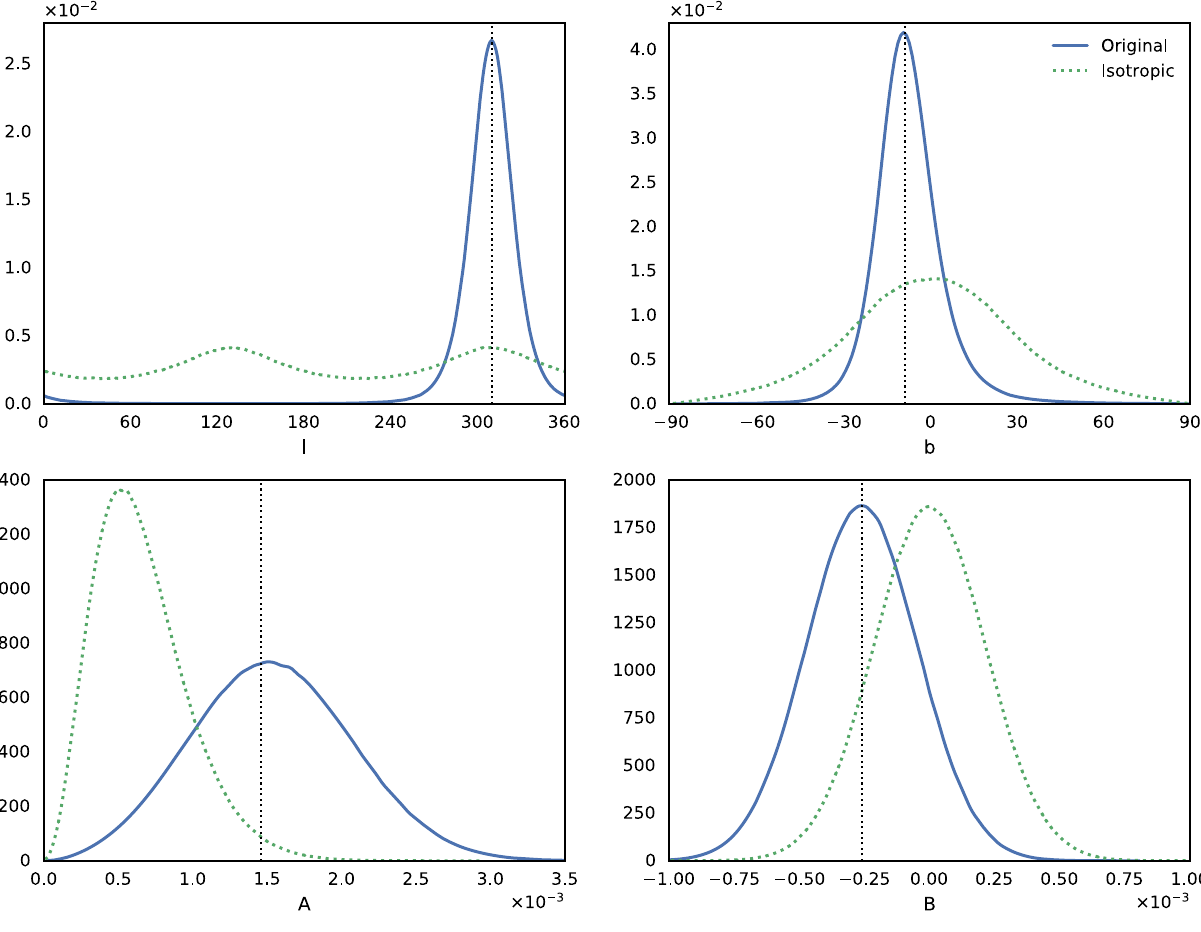
Fig. 5 Blue lines show marginalized likelihoods of dipole A , monopole B and ( l , b ) for Union2.1 data set, and black vertical lines represent best-fitting values. Green dotted lines represent results of “isotropic”